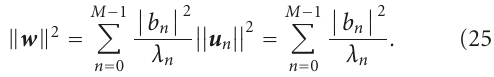
maximum design frequency [6]. Space-time sampling